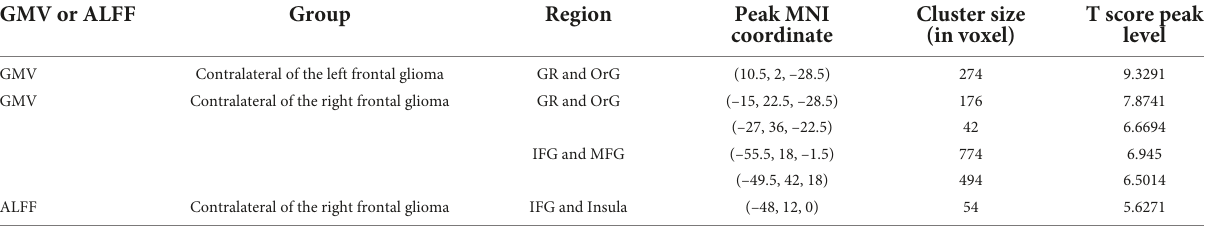
Cluster size T score peak coordinate (in voxel) level